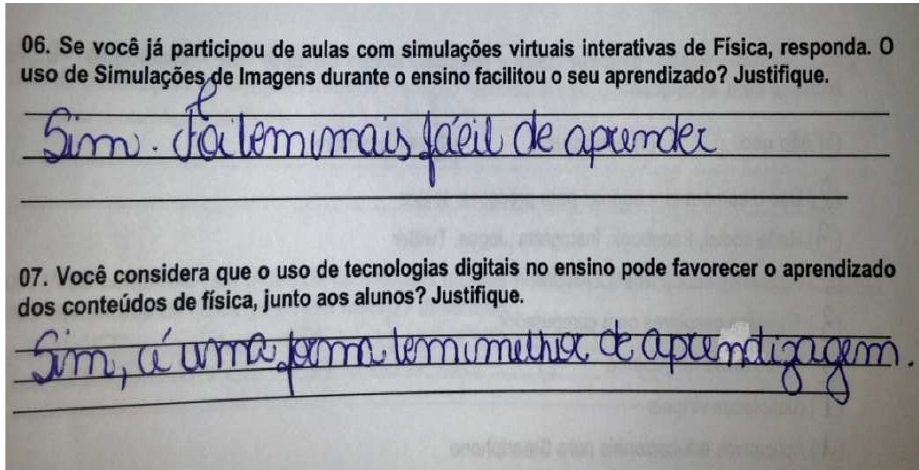
Figure 4: Example of a response given by a student at school